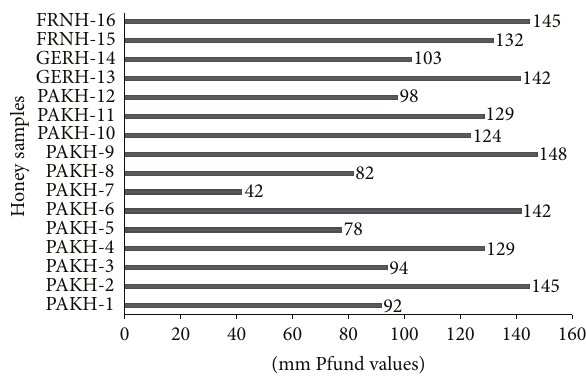
Figure 1: Color characteristics of local and exotic honey samples.